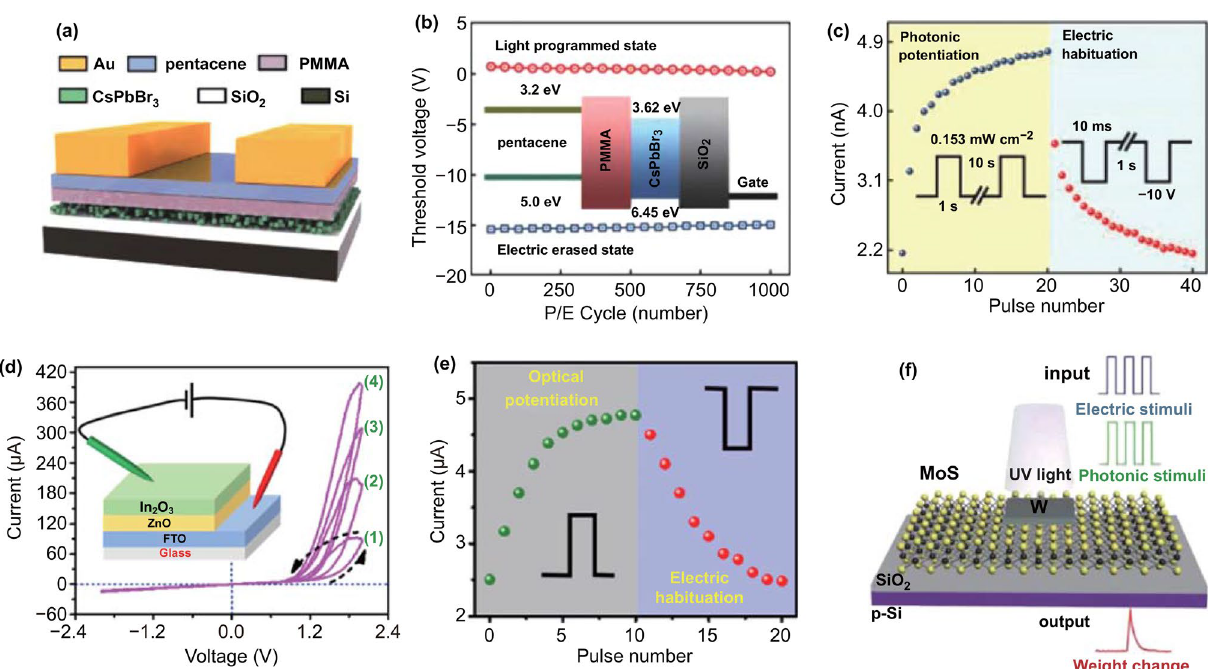
Fig. 8 a Schematic of the CsPbBr 3 quantum dot-based synaptic device. b Schematic of the device energy band diagram. c Photonic potentia- tion in response to optical pulses and depression in response to electrical pulses under dark condition. a – c Reproduced with permission from Ref. [137]. d In 2 O 3 /ZnO/FTO-based synaptic device and its I–V characteristic at different cycles. e Current changes for the synaptic devices in response to excitatory optical pulses and inhibitory electrical pulses. Top and bottom insets show the shape of the pulses. d , e Reproduced with permission from Ref. [94]. f Schematic of an optoelectronic synergetic synapse device based on monolayer MoS 2 . Reproduced with permission from Ref.